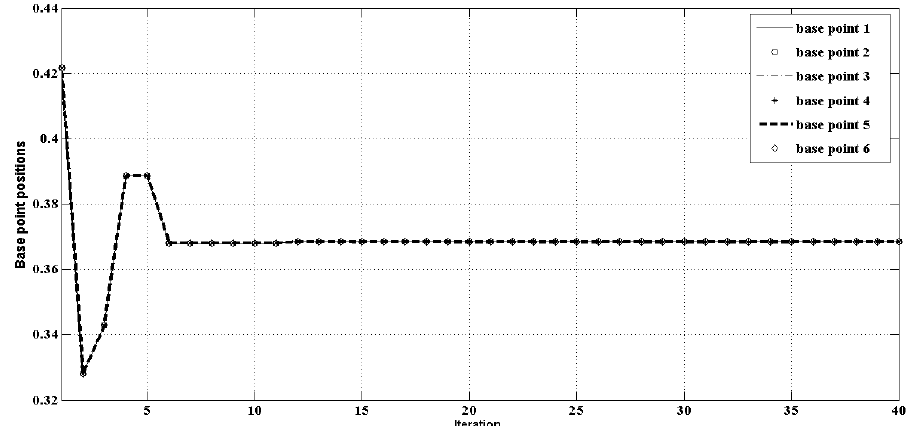
Figure 5. Base point position versus iteration number for base point locations being displaced equidistantly.